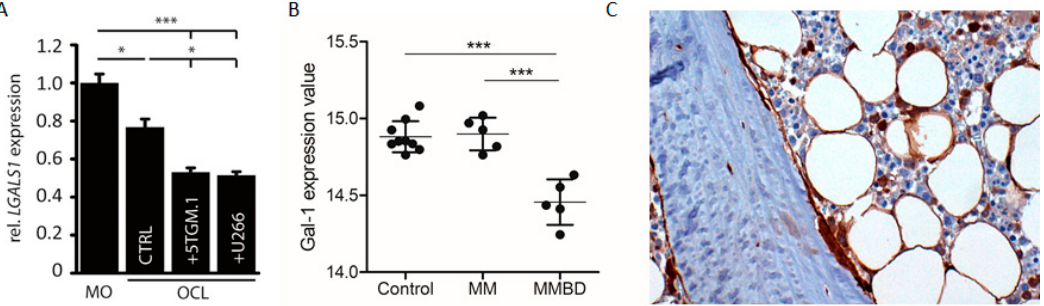
Figure 5. Myeloma cells induce decreased gal-1 levels in mature osteoclasts. ( A ) Relative galectin-1 mRNA expression to monocytes cultures in osteoclast culture (CTL), osteoclast-5TGM-1 and -U266 transwell co-cultures. (MO: monocytes; OCL: osteoclasts) ( B ) Gal-1 mRNA expression in primary BMSCs (publicly available dataset: GSE85837) of donors without malignant BM involvement (control; n = 9), MM patients without bone involvement (MM; n = 5) and MM patients with bone disease (MMBD; n = 5). ( C ) Gal-1 protein was evaluated by immunohistochemistry in fixed bone biopsies obtained from 15 MM, 9 asymptomatic MM and 10 MGUS patients. The photo shows gal-1 protein immunostaining of osteomedullary biopsies from one representative asymptomatic MM patient Magnification 20× (Materials & Methods: [2]). Data in Figure 5A are representative of three ( n = 3) biologically independent experiment. Data in Figure 5B are representative of one analysis ( n = 9 control; n = 5 MM; n = 5 MMBD). All results are represented as mean +/ − standard error. * p < 0.05; *** p < 0.001.